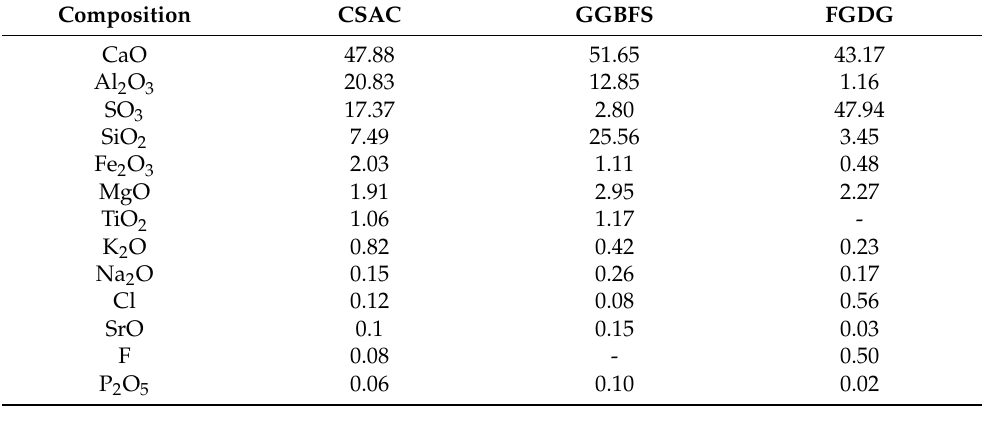
Table 1. Chemical compositions of raw materials (wt %) [18].